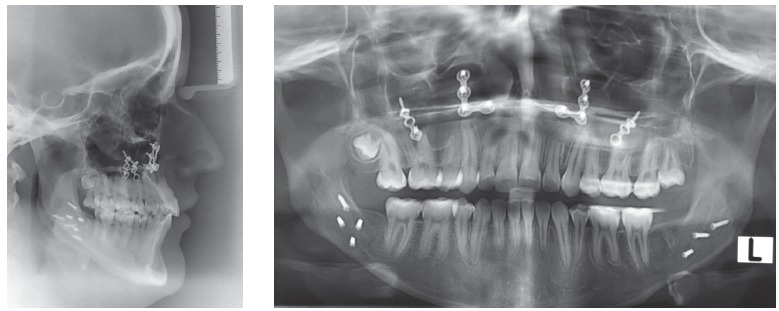
Final radiographs.